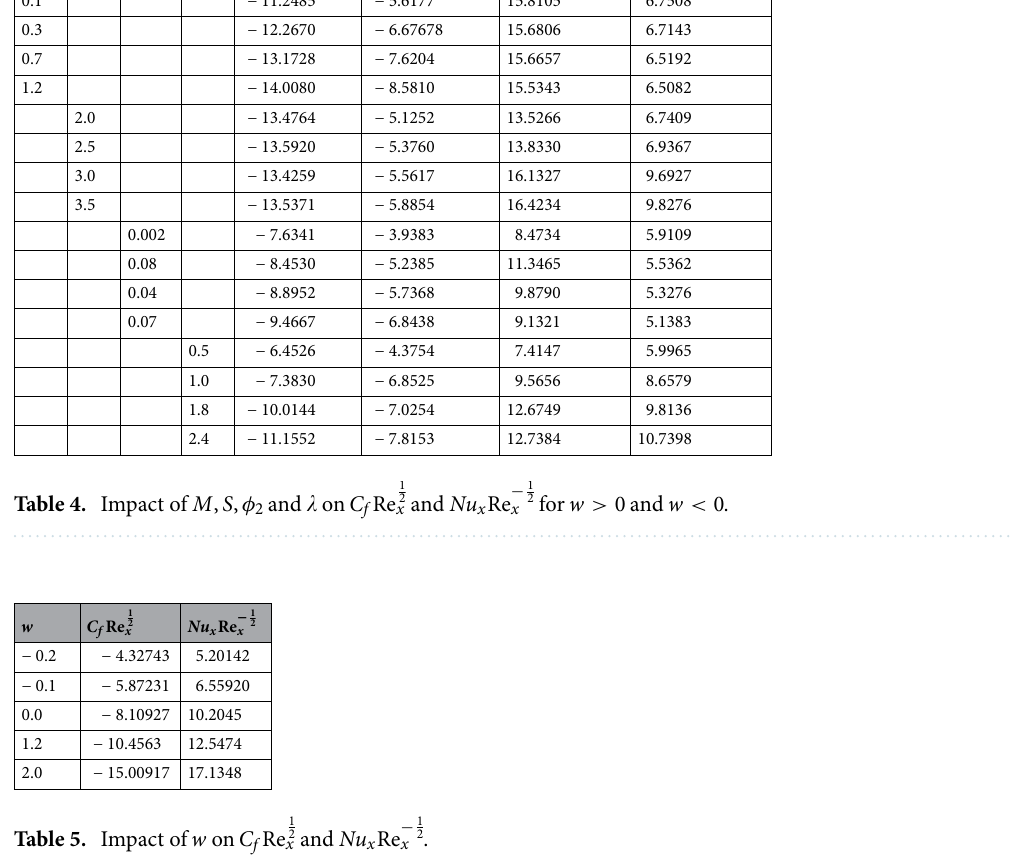
Table 5. Impact of w on C f Re